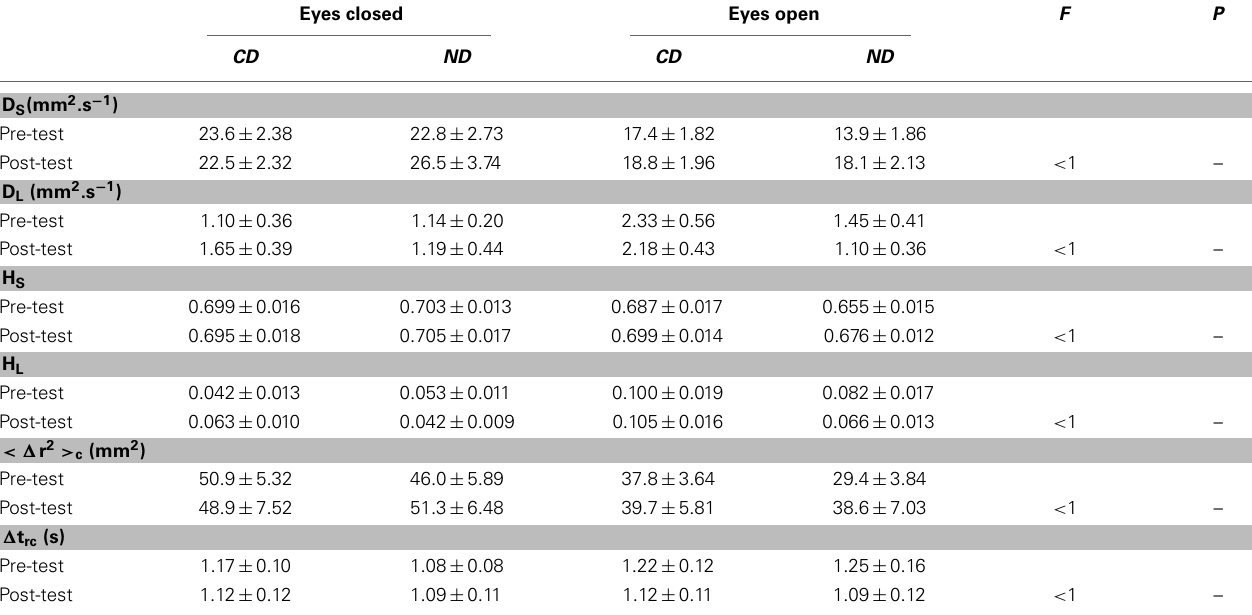
Table 3 | Mean ± SE of signal diffusion analysis for the groups of participants (CD, contemporary dance; ND, no dance). Eyes closed Eyes